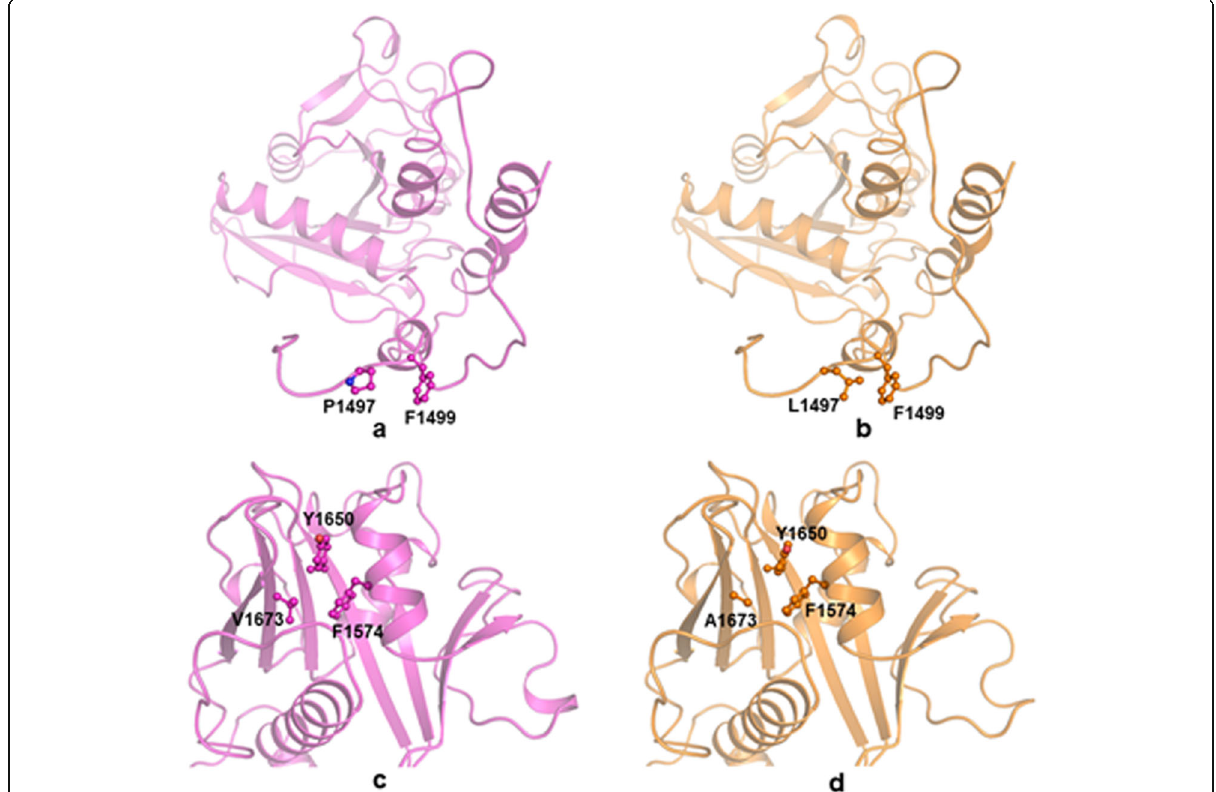
Fig. 6 Cartoon representation of GTPase (GAP) domain of wild type (magenta) TSC2 in ( a and c ) and mutants (orange) in ( b ) Pro1497Leu and ( d ) Val1673Ala. Important residues have been represented in ball and stick